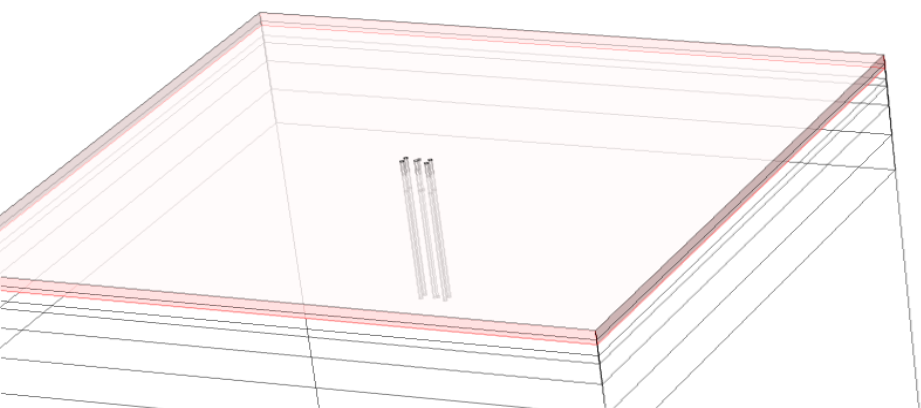
Figure 2. Simulation of the Lambeth College energy pile test in 3D.